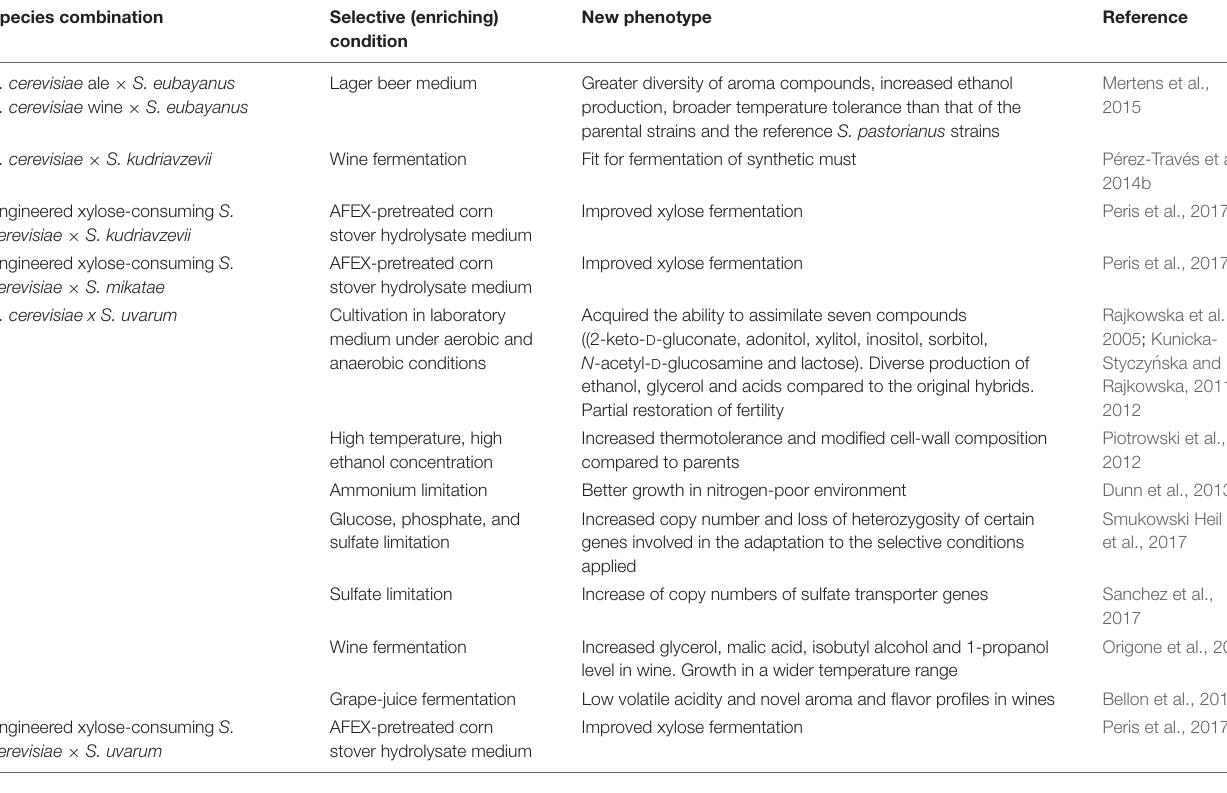
TABLE 2 | Examples of mitotic segregants of interspecies hybrids.